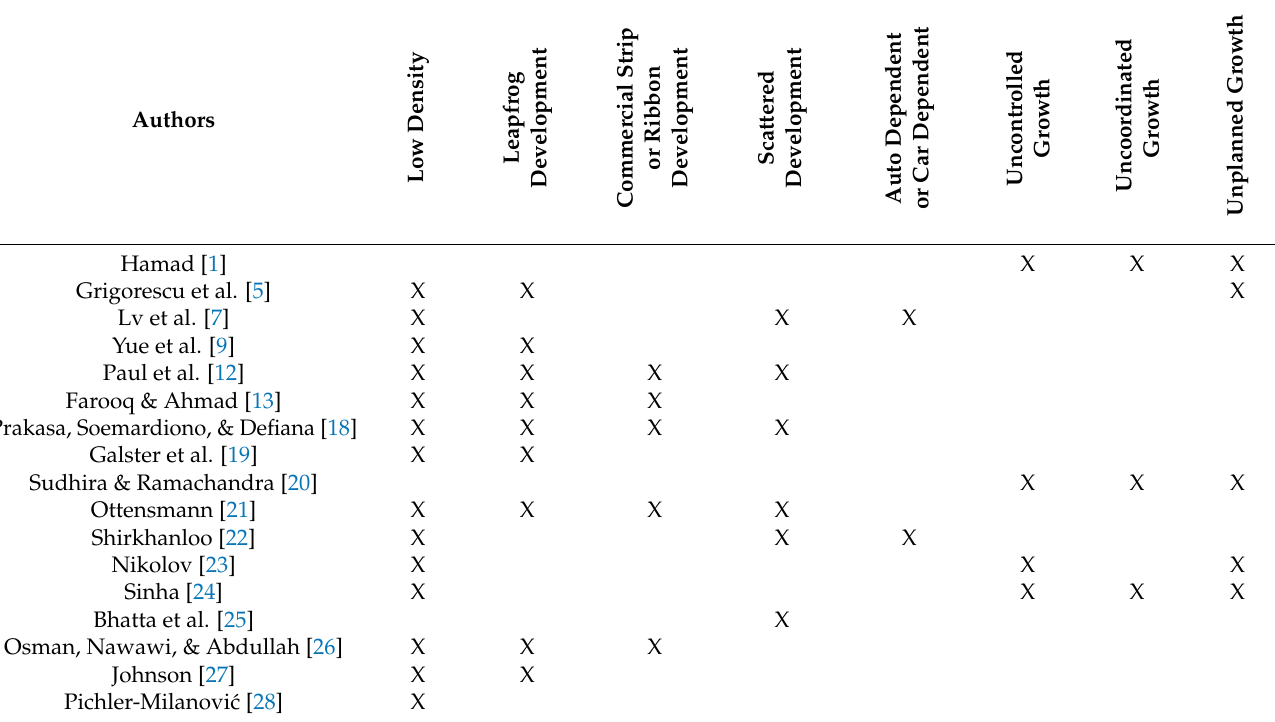
Table 1. Summary of characteristics for urban sprawl based on previous